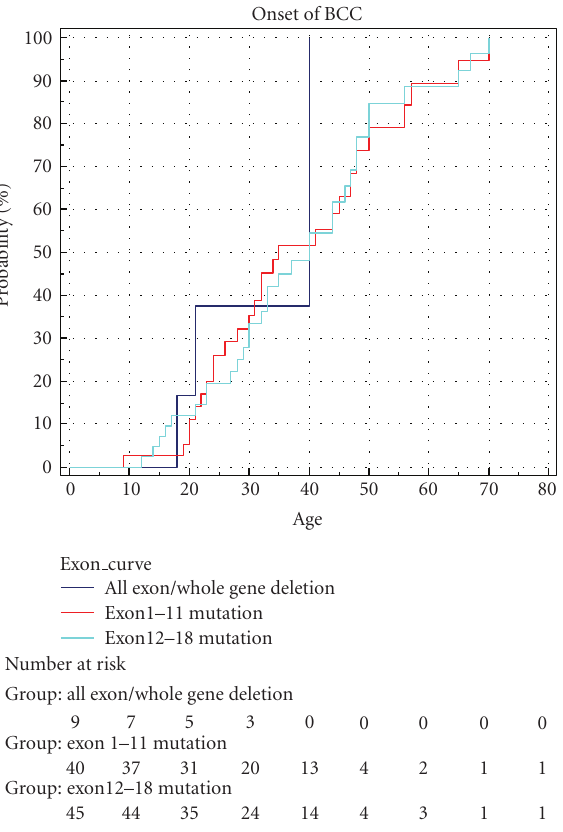
Figure 4: E ff ect of mutation position on onset of